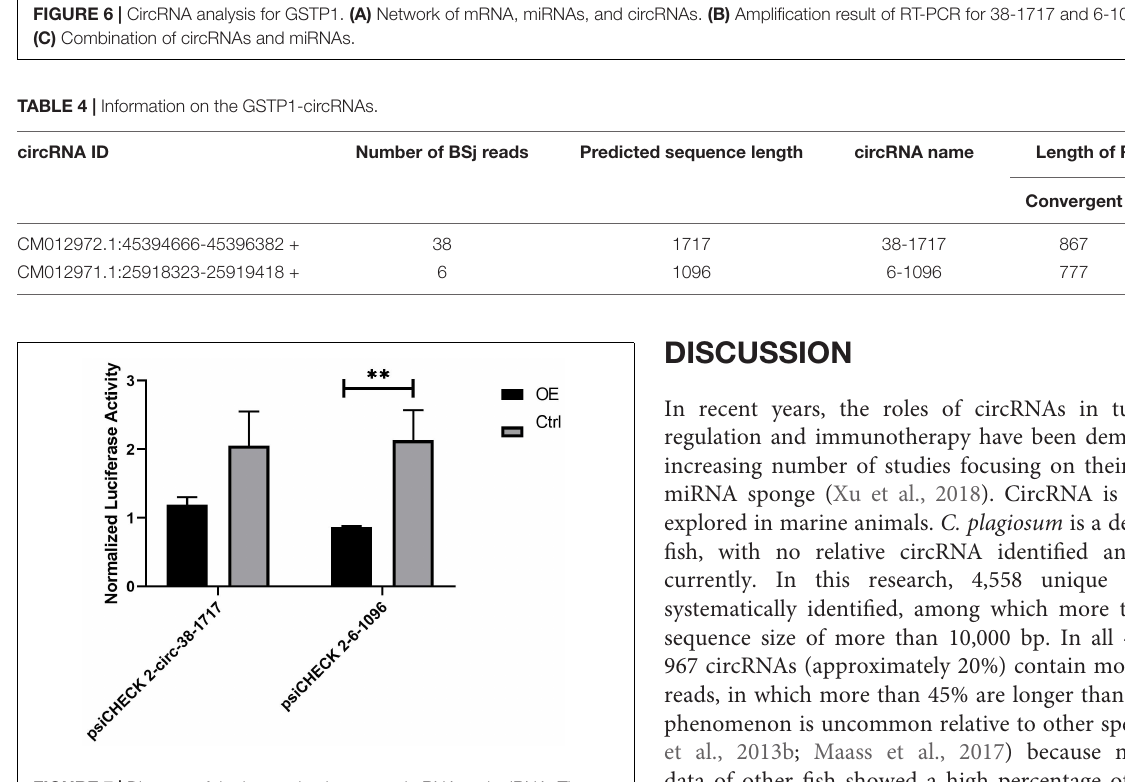
FIGURE 7 | Diagram of the interaction between circRNA and miRNA. They are the psiCHECK 2-circ-38-1717-OE group and psiCHECK 2-circ-6-1096-OE group and its corresponding control group. The t -test analysis shows that psiCHECK 2-circ-6-1096-OE and its control group have significant difference. Statistical analysis was performed by Prism 8, ∗∗ P ≤ 0.01, indicated significant